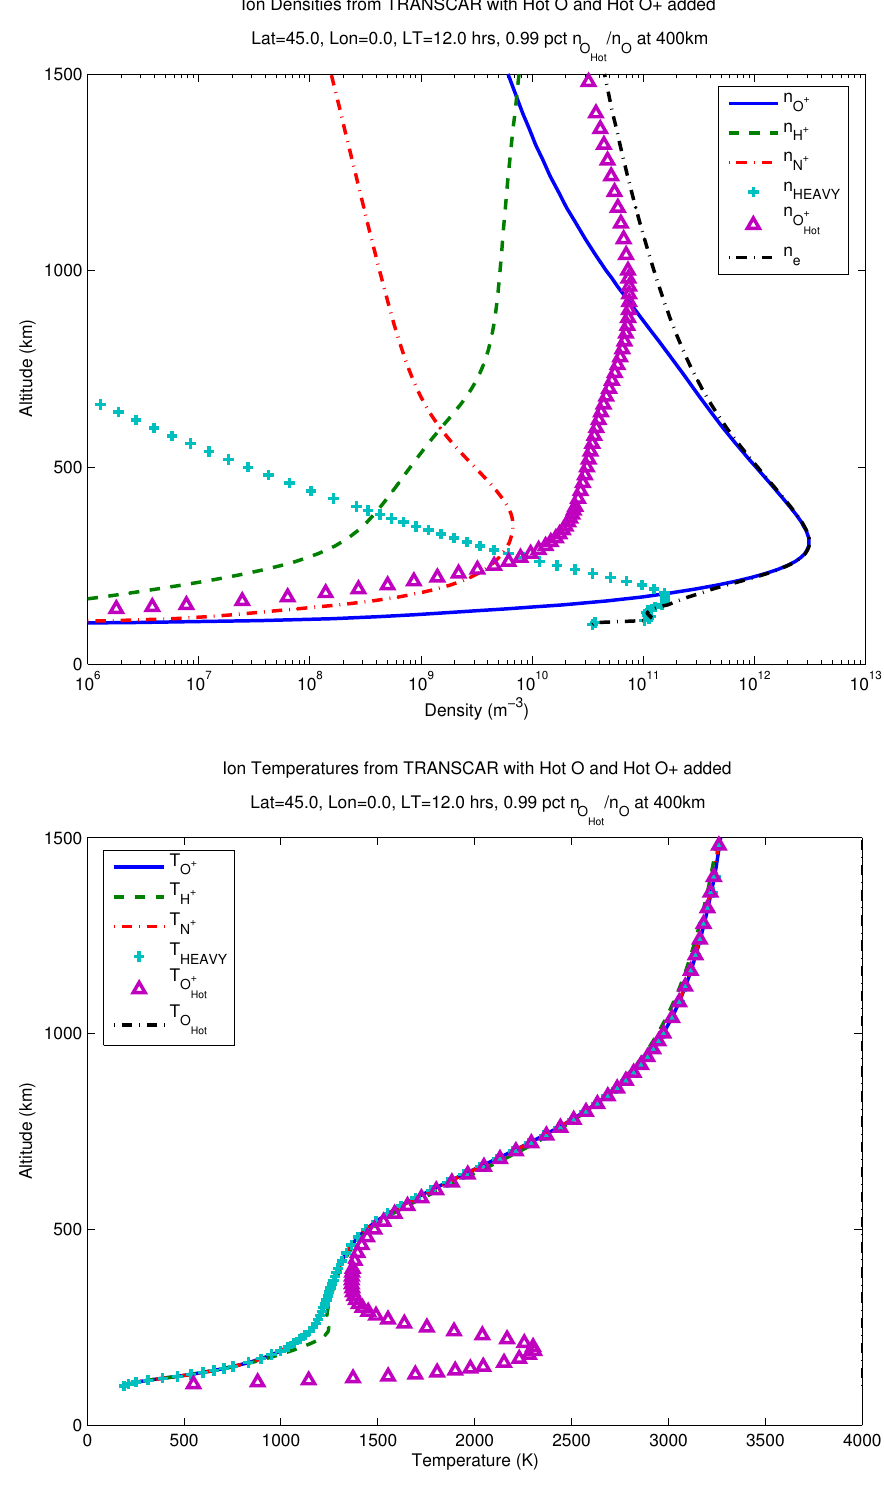
Fig. 4. Ion densities n s and temperatures T s as simulated in TRANSCAR. This simulation includes our self-consistently modeled population of hot O + .